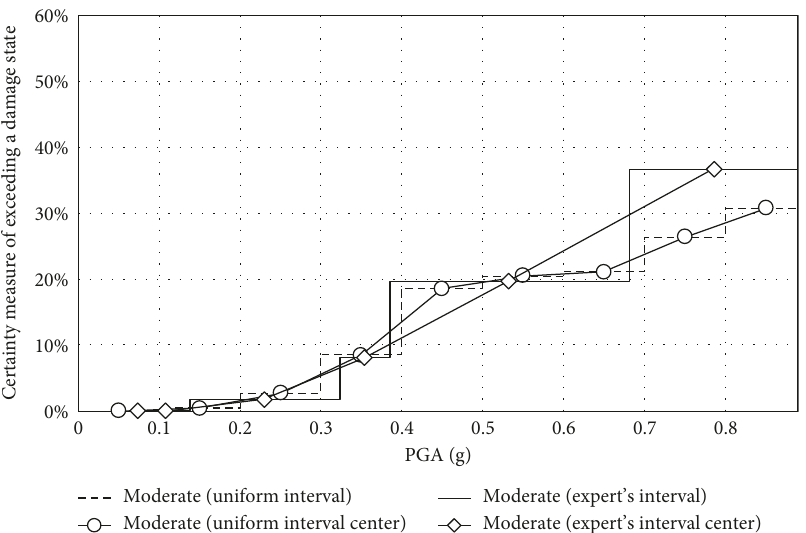
Figure 12: Comparison of the proposed fragility curves for Moderate about the different interval selections with alternative formulation of the proposed fragility curves by using step function and connecting the necessity measure at the center of PGA interval.